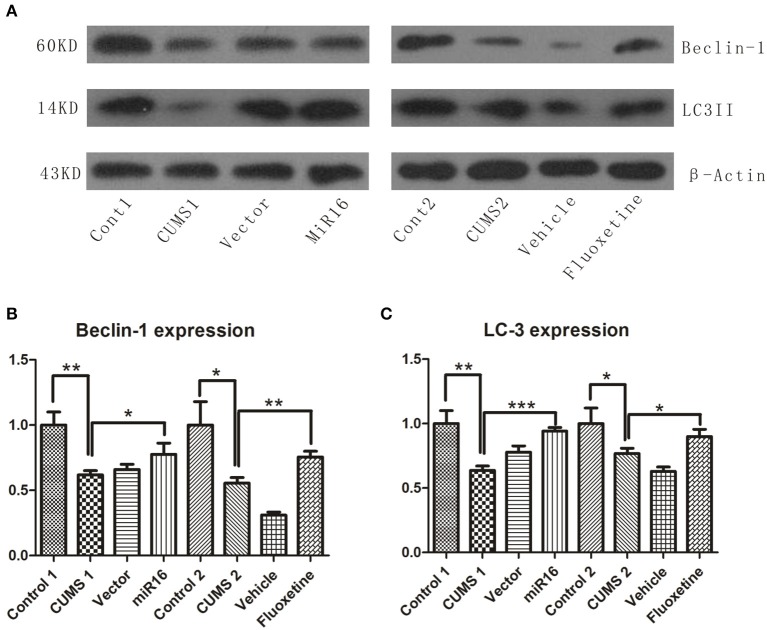
The expression levels of Beclin-1 and LC3II were detected by Western blot and revealed an autophagic decrease after CUMS. Western blot analysis of protein levels of Beclin-1 and LC3II in the rat hippocampus derived from each group. (A) The bands shown in the image presented a similar trend of Beclin-1 and LC3II expressions. Compared to the Control, the CUMS groups showed a significant decrease, while both miR-16 and Fluoxetine treatment bring back, to some extent, the change. Histograms from Beclin-1 protein levels (B) and LC3II (C) present the mean change, values are the means ± SEMs. *P < 0.05; **P < 0.001; ***P < 0.0001.